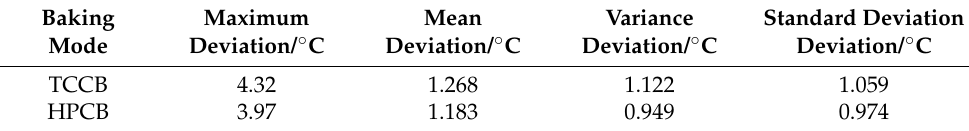
Figure 2. Temperature value of the TCCB and HPCB systems. Table 5. Analysis of variance between TCCB and HPCB and process set curve.